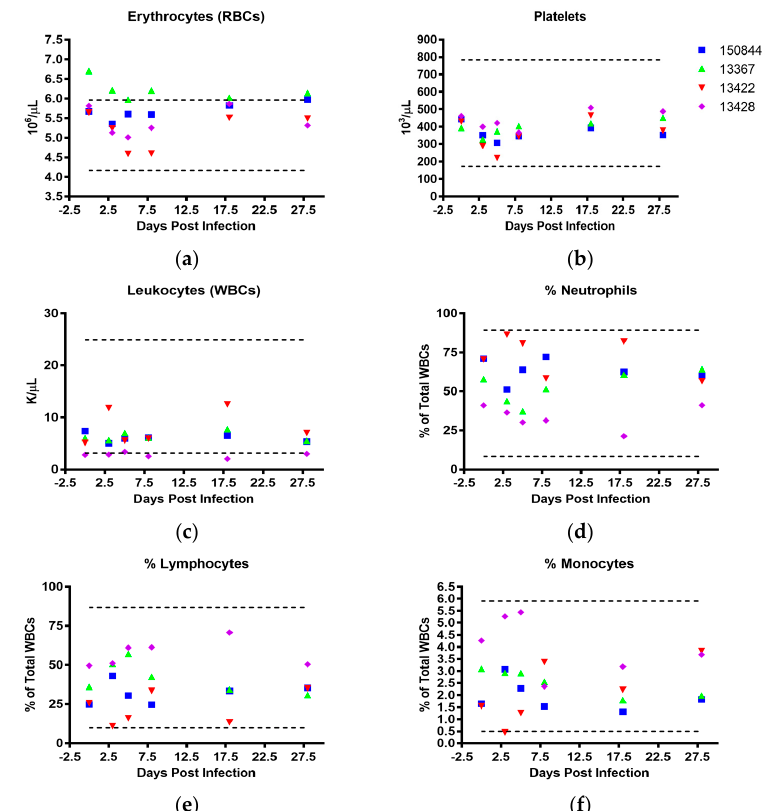
Figure 5. Hematological Values. Whole blood collected in K 2 EDTA tubes was utilized to perform complete blood counts using the HemaVet 950 system. ( a ) erythrocytes in 10 6 / μ L, ( b ) platelets in 10 3 / μ L, ( c ) leukocytes in K/ μ L, ( d ) neutrophils as % of total leukocytes, ( e ) lymphocytes as percentage of total leukocytes, and ( f ) monocytes as % of total leukocytes. Macaque 150844 seen in blue, 13367 in green, 13422 in red and 13428 in purple. Dotted lines represent upper and lower reference ranges for analytes.